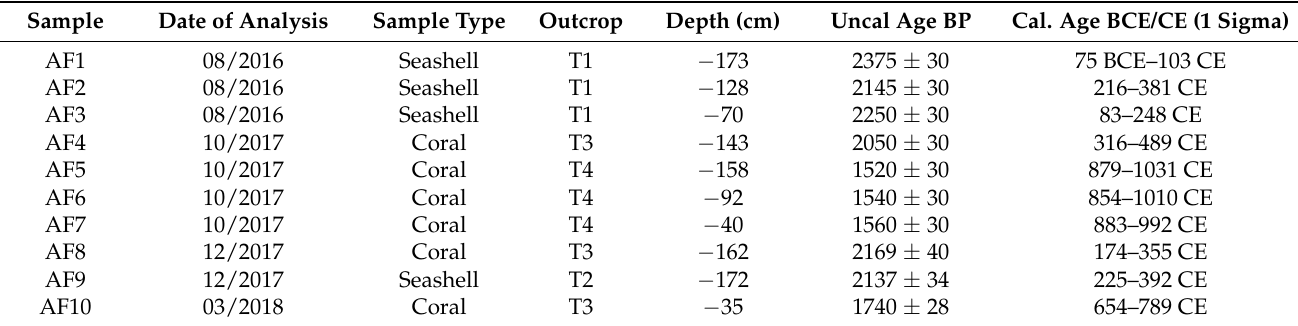
Table 5. Radiocarbon dates for samples from the abandoned fishponds in Kiantar Village.